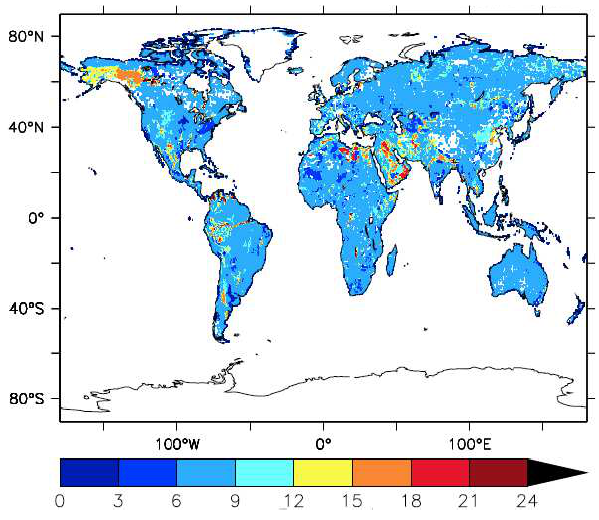
Fig. 5. Mica content in the silt fraction of